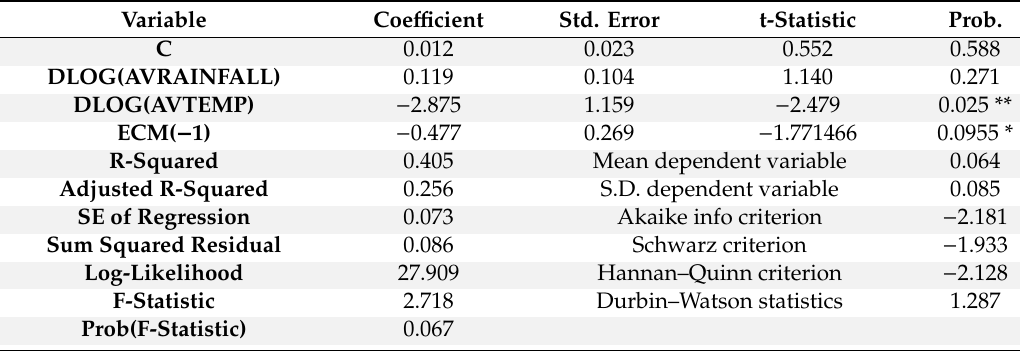
Table 5. Results from the Error Correction